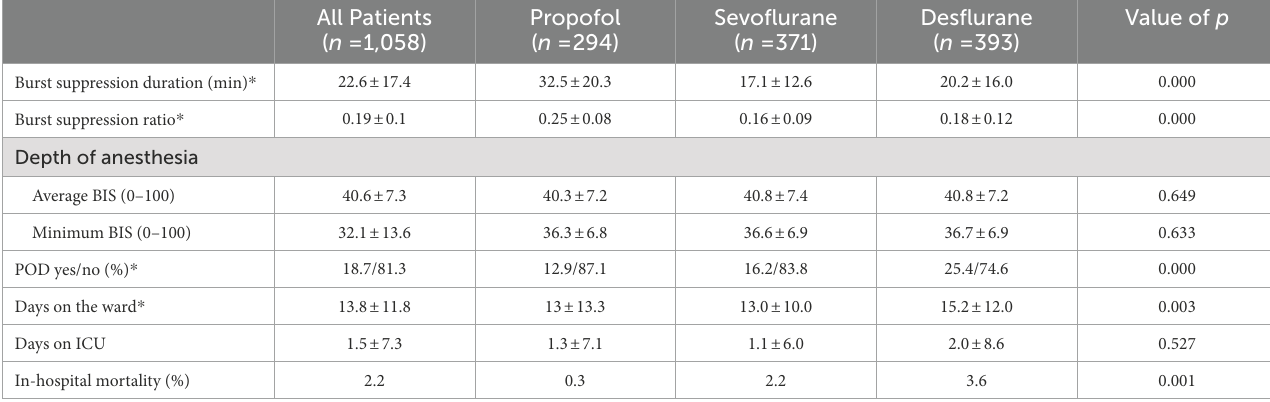
TABLE 2 Outcome parameter for the anesthetic agent given throughout anesthesia maintenance.